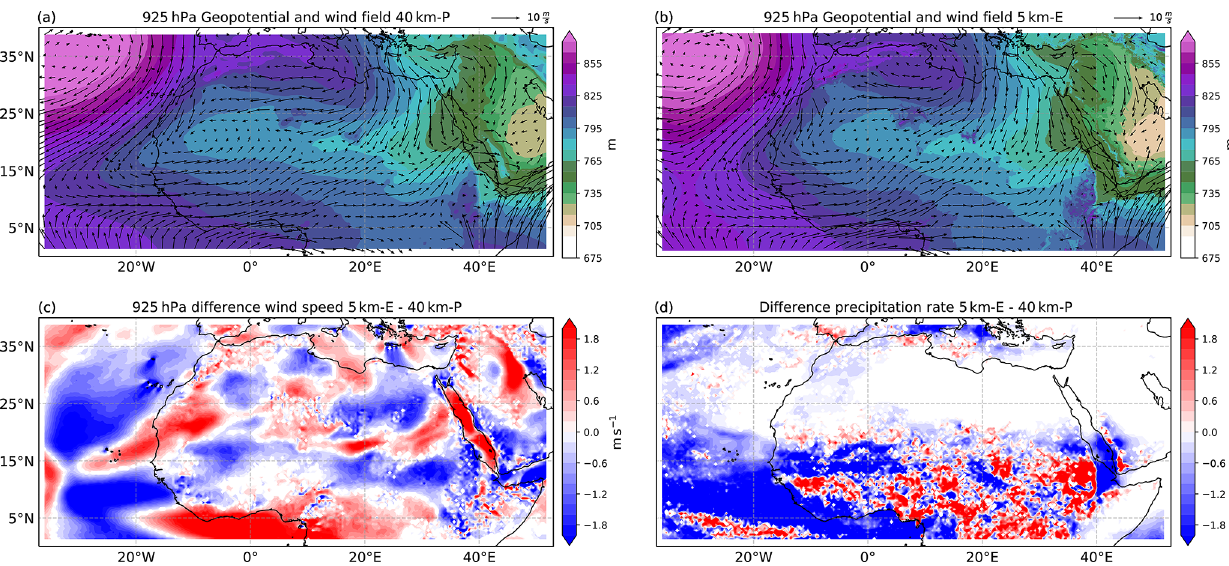
Figure 5. JAS mean geopotential height (shading) and mean wind field (vectors; ms − 1 ) at 925hPa for the 40km-P (a) and the 5km-E simulations (b) , the difference in JAS mean wind speed at 925hPa (c) and the difference in JAS mean precipitation rate (d) between the 5km-E and 40km-P simulations, respectively. White colors in panels (c, d) display difference values between − 0.1 and 0.1.